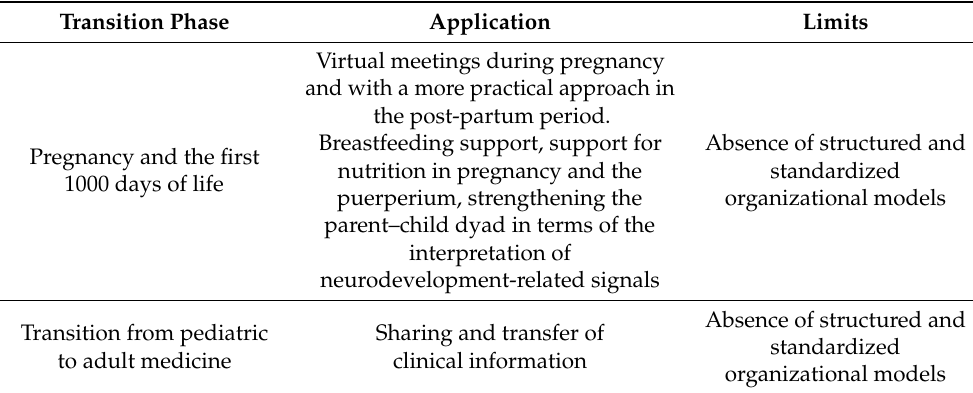
Table 5. Telemedicine in children and adolescents in transition stages of